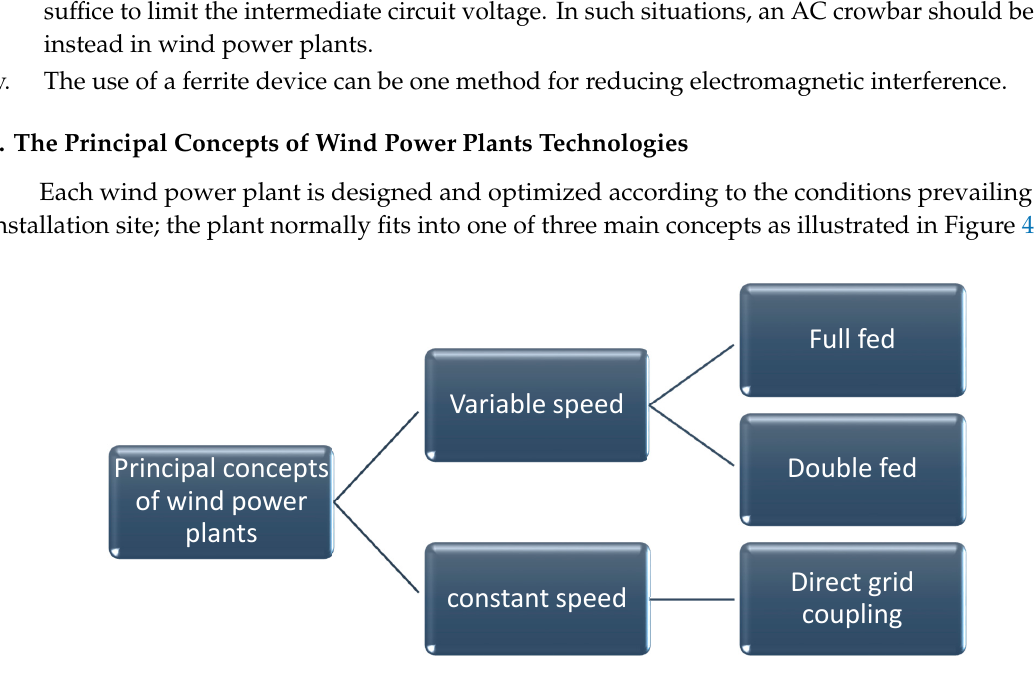
Figure 4. Principal concepts of wind power plants.